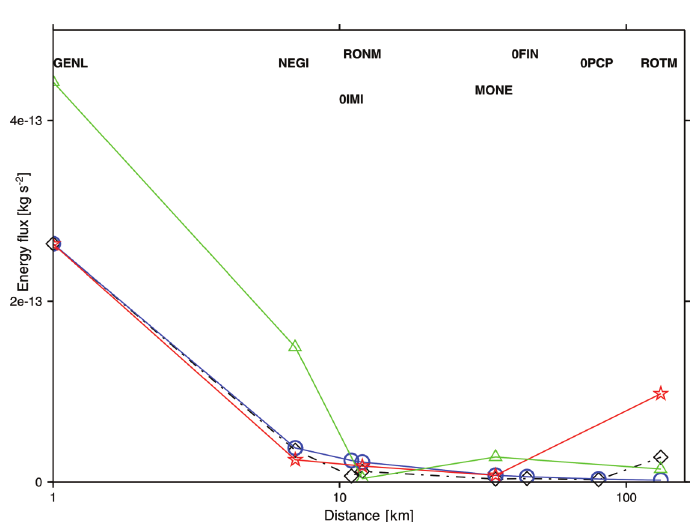
Fig. 9. Energy attenuation for each component with increasing distance computed in the frequency window 2- 10 Hz. Each symbol represents the energy computed at the relevant station. To fit all curves in one plot, the two transversal components (red and green line) are multiplied by 1e-6; no exaggeration has been applied to the ver- tical component (dotted line). The shape of the curve attenuating with R − 1 is reported for comparison (blue